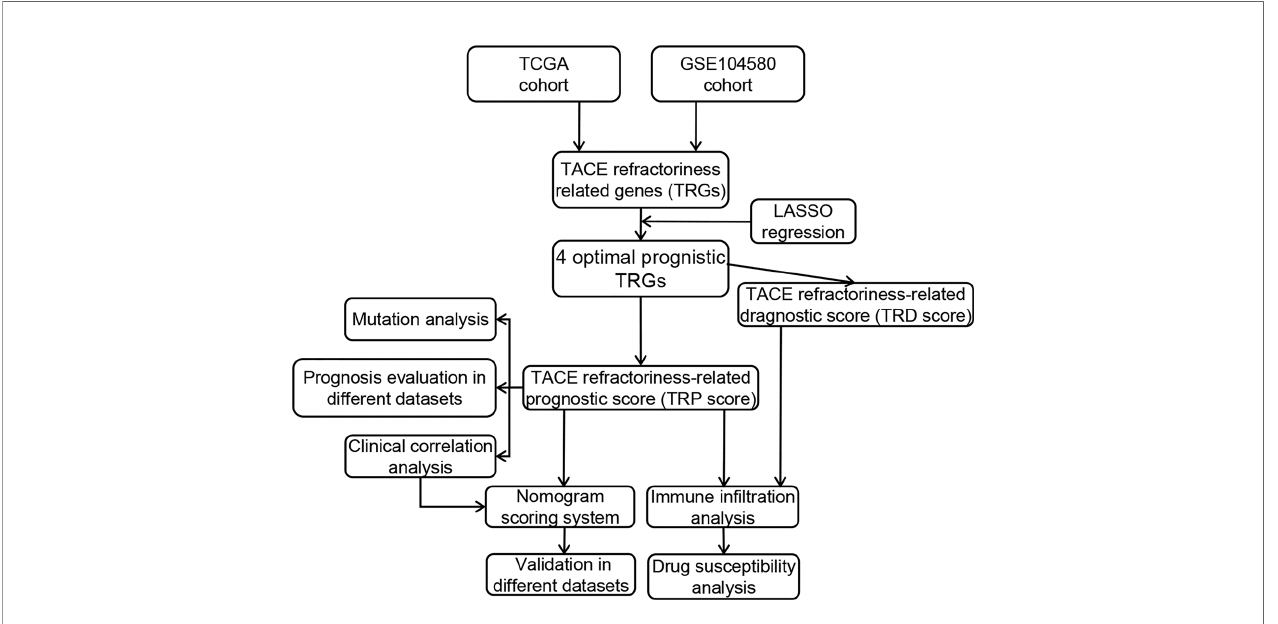
FIGURE 1 | Flowchart of our